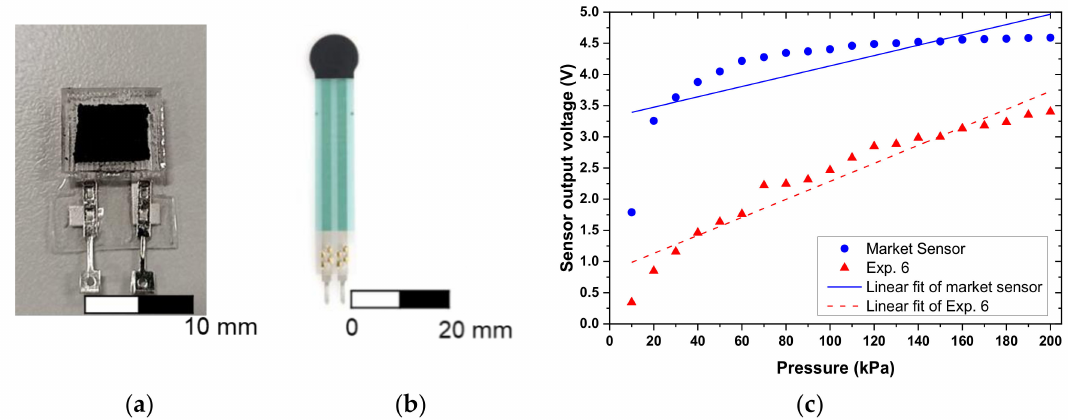
Figure 26. An image of the ( a ) proposed tactile sensor and ( b ) commercially available piezoresistive force sensor. ( c ) Com- parison of the sensor response observed for the proposed tactile sensor and commercial sensor in the pressure range of 0–200